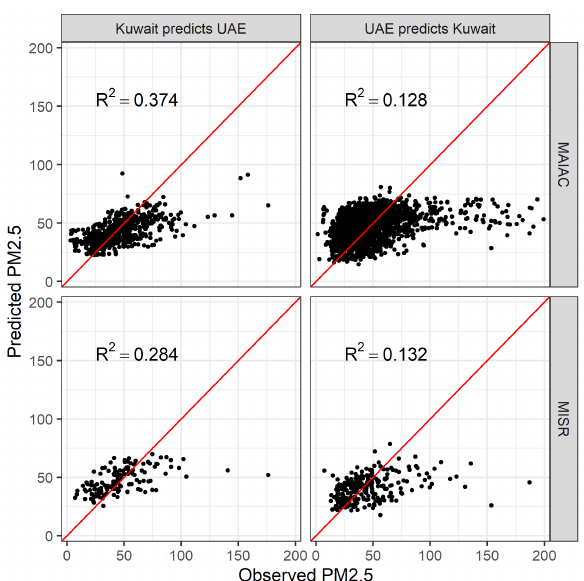
Figure A1. Out-of-region PM 2.5 predictions for Kuwait-trained models over the U.A.E. ( left column ) and out-of-region PM 2.5 predictions for U.A.E.-trained models over Kuwait ( right column ) by MAIAC and MISR AODs (top and bottom rows, respective).